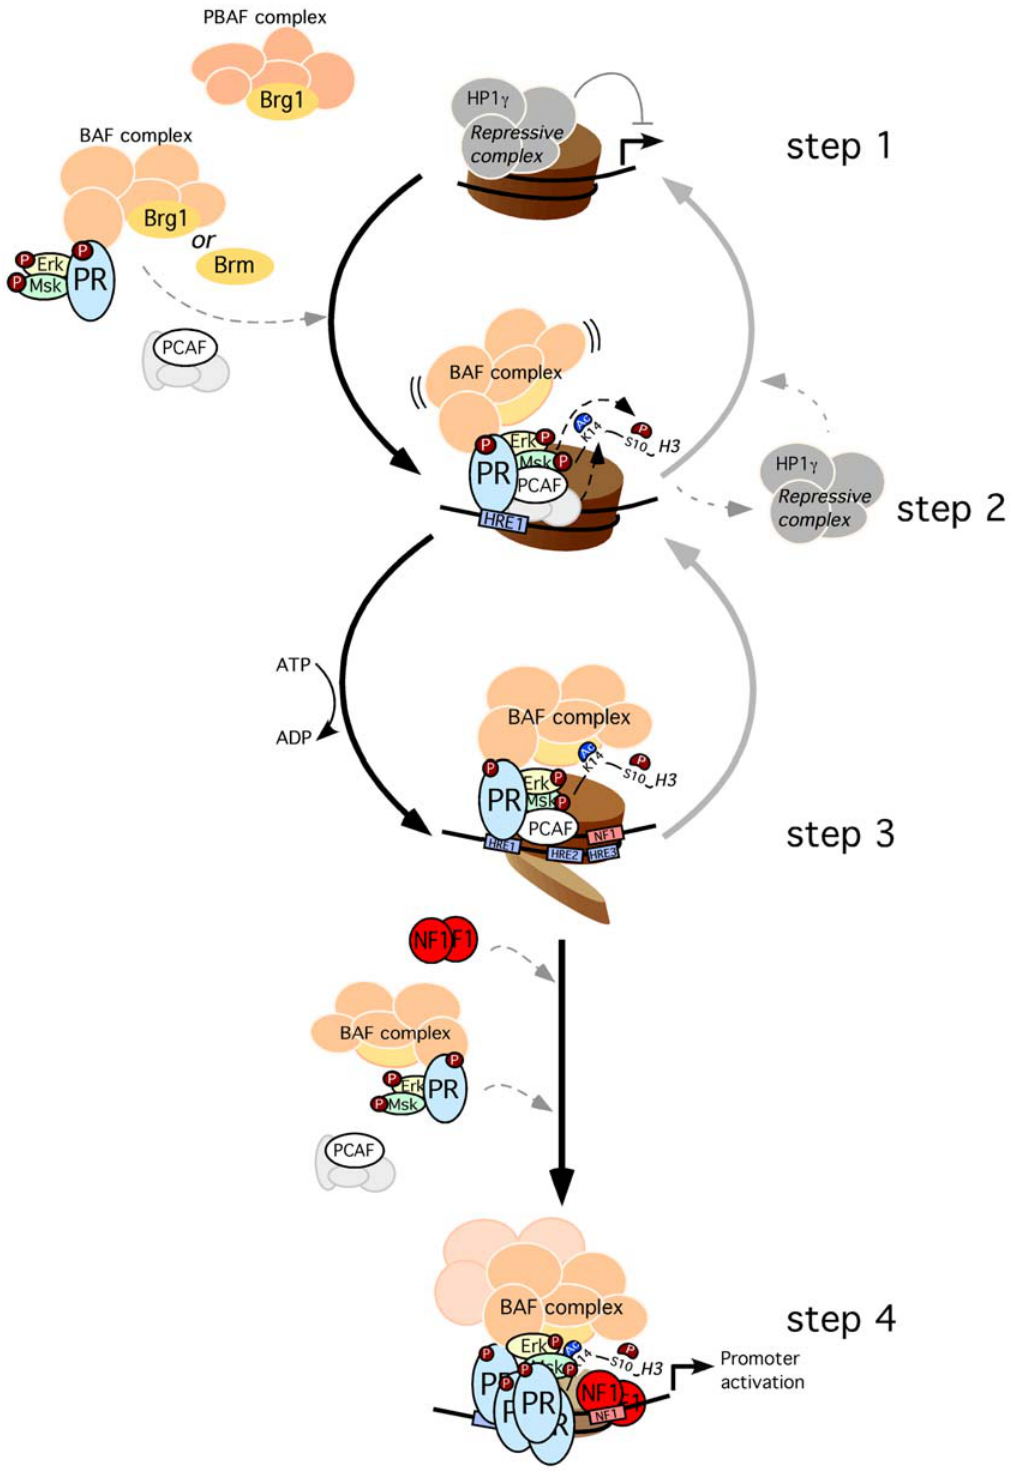
Figure 5. Model for the initial steps of MMTV promoter activation. Before hormone addition the MMTV promoter is silent and associated with a repressive complex that includes HP1 c (step 1). After hormone addition the activated complex of pPR-pErk-pMsk, as well as PCAF and BAF, are recruited to the MMTV promoter. For simplicity PR is shown as a monomer, though the active form is a homodimer. Msk and PCAF phosphoacetylates H3 leading to H3S10phK14ac (step 2). This modification displaces the repressive complex and anchors the BAF complex, enabling ATP-dependent H2A/H2B displacement (step 3). The nucleosome opening facilitates NF1 binding generating a stable platform that exposes previously hidden HREs for the recruitment of additional PR and BAF complexes, coactivator and eventually promoter activation (step 4). Depletion of BAF prevents progression of the activation process to step 2: no histone displacement is observed, NF1 cannot bind and consequently less PR/BAF complexes are bound to the promoter. Depletion of PCAF has a similar effect, most likely by labilization of BAF binding, blocking the activation process at step